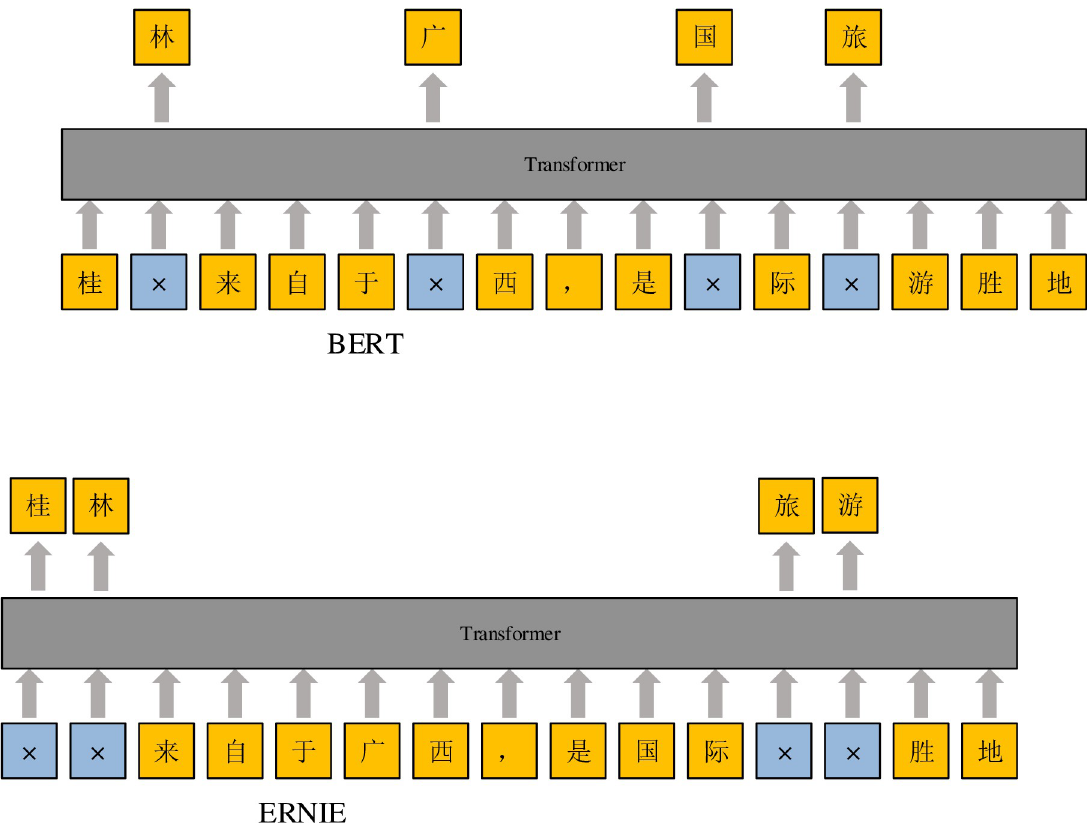
Fig 3. Differences in the mask strategies between the BERT model and ERNIE